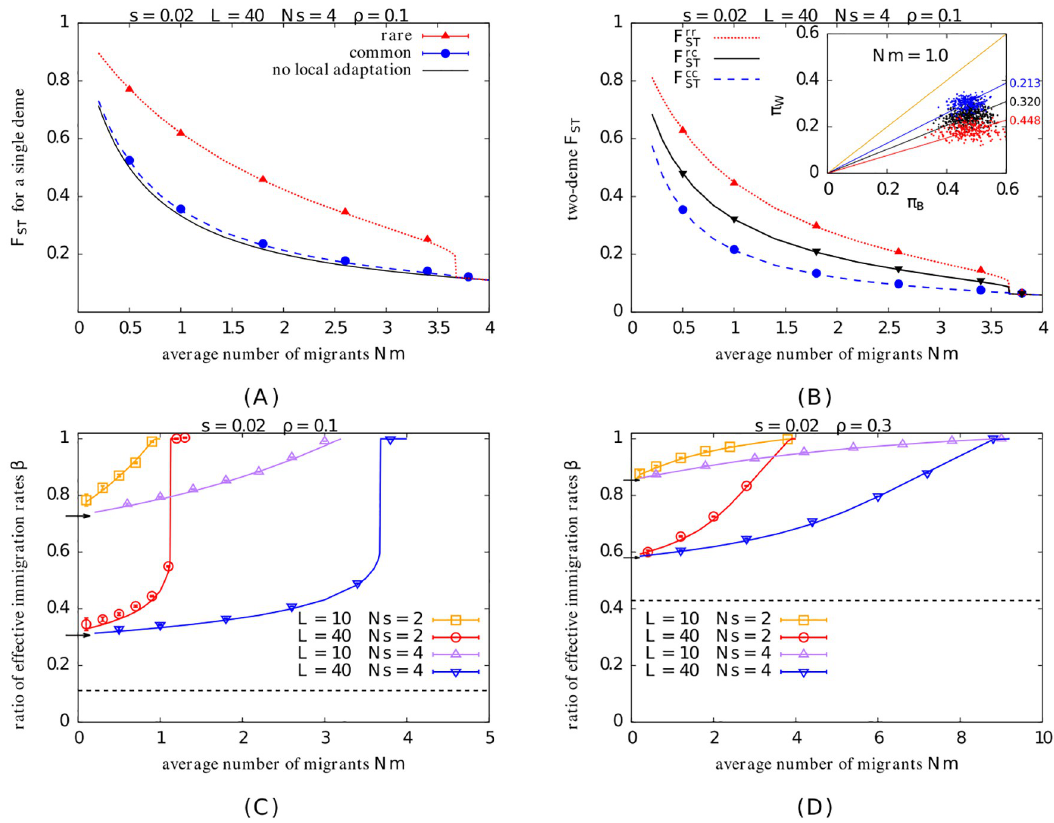
Fig 3. Neutral divergence in the infinite-island model. A. Average F ST for a single deme in the rare ð F ð r Þ Þ and common ð F ð c Þ Þ ST ST habitats vs. Nm , for s =0.02, L =40, Ns =4, ρ =0.1. Here, F is measured relative to the whole metapopulation. Symbols show results of ST individual-based simulations; dashed lines represent theoretical predictions (obtained from Eq (9a), (9b) and (9f) and using Eq (5)); the solid black line represents F =1/(1+2 Nm )– the prediction in the absence of local adaptation. B. Average F for a pair of demes ST ST ), or both to the vs. Nm , for the same parameters as in Fig 3A. Here, both demes within the pair may belong to the rare habitat ( F ð rr Þ ST ), or one to the rare and the other to the common habitat ( F ð rc Þ ). The plots show simulation results (symbols) as common habitat ( F ð cc Þ ST ST well as theoretical predictions (lines; obtained from Eq (9c)–(9f) and using Eq (5)). Inset (Fig 3B): The neutral diversity within demes for rare/rare, common/common and rare/common pairs of demes (shown using red, π W vs. neutral divergence between demes p B blue and black points respectively), for Nm =1.0, as measured at a single timepoint in an individual-based simulation. Each point P P 40 40 represents a pair of demes ( i , j ); π is computed as 1 = 40 ð 2 p þ 2 p Þ = 2 and π as 1 = 40 ð 2 p þ 2 p Þ = 2 , q q q q W B i ; k i ; k j ; k j ; k i ; k j ; k j ; k i ; k k ¼ 1 k ¼ 1 where p i , k represents the allele frequency at the k th neutral locus in deme i and q i , k =1 − p i , k . The solid lines represent ( π W , π B ) values of 0 (orange), 0.213 (blue), 0.320 (black), 0.448 (red): the last three are the combinations that would correspond to F ST ð r Þ , F ð cr Þ and F ð rr Þ at Nm =1 respectively. C– D. b ¼ ð 1 = F vs. Nm for ρ =0.1 (Fig 3C) and ρ =0.3 (Fig 3D), for different predicted F ð cc Þ ST Þ(cid:0) 1 ST ST ST ð 1 = F ð c Þ ST Þ(cid:0) 1 values of L and Ns (depicted by the different colors) and s =0.02. The quantity β gives the ratio of the effective number of immigrants per unit time into an island in the rare habitat to the corresponding number for an island in the common habitat. Theoretical predictions (solid lines) match simulation results (symbols) across all parameter combinations. The black dashed line in each plot represents the threshold β min = ρ /(1 − ρ ), which is the expected β under complete RI (wherein immigrants from the dissimilar habitat have zero RV). The short horizontal arrows along the vertical axis represent the threshold β =( β min + e − 2 Ls )/(1+ β min e − 2 Ls ) for L =10 (upper arrow) and L =40 (lower arrow). This is the expected value of β when allele frequency divergence between habitats is maximum (see text). F ST values in simulations are computed from 40 unlinked neutral